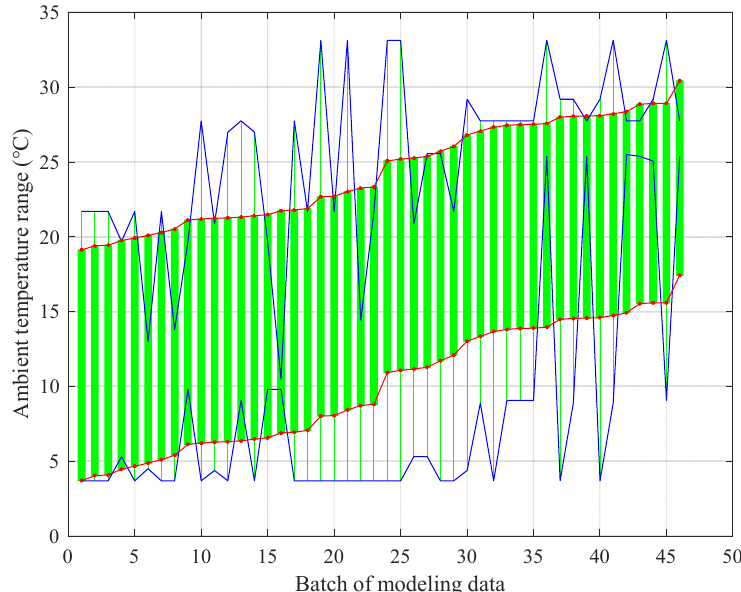
Figure 7. Applicable ATIs of TEPMs of 46 batches of experiments.